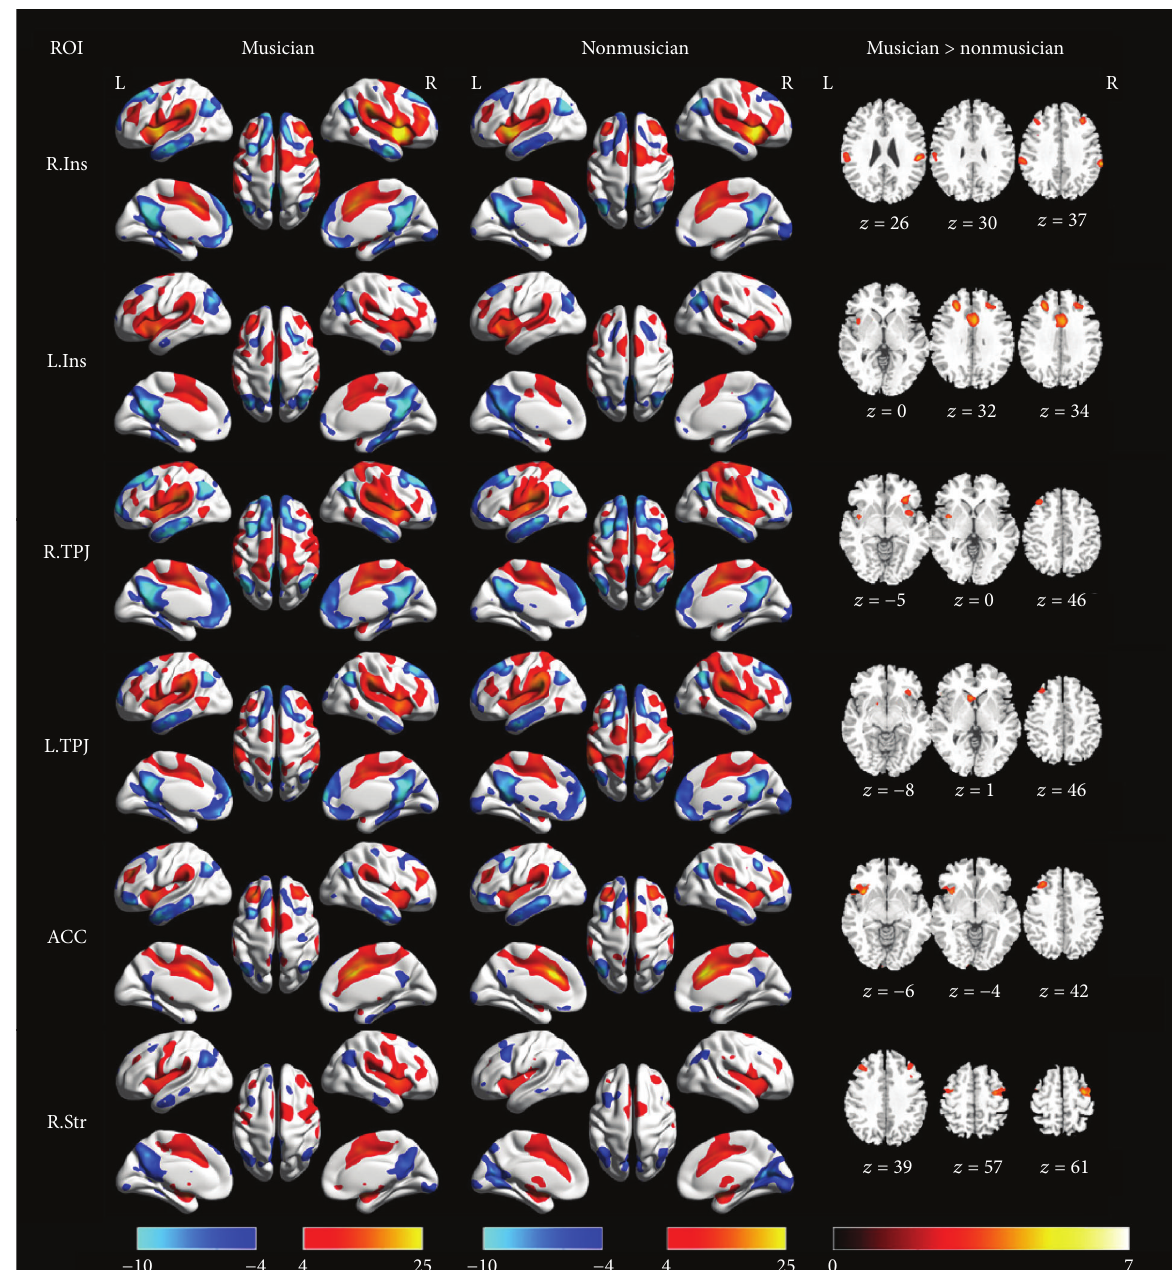
Figure 5: The group-level functional connectivity maps seeded at 6ROIs and their difference between musicians and nonmusicians. The first column shows the seeds; the second and the third column illustrated the positive (hot color) and negative (cool color) functional connectivity with the seeds rendered onto a three-dimension brain reconstruction. The last column (axis images) represents significantly increased functional connectivity in musicians compared with nonmusicians. ROIs’ abbreviations are consistent with those shown in Table